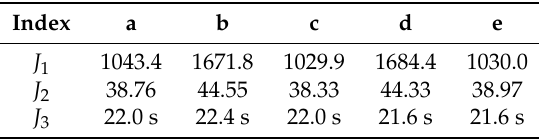
Table 2. Cost indexes for each